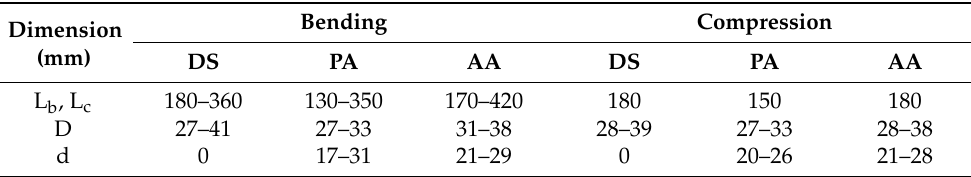
Table 3. Dimensions of the specimens for mechanical tests. L b is the clear span in flexural test (distance between nodes), L c is the sample length in compression test, D is the diameter of the cross- section of a piece of bamboo taken as the average of two perpendicular measurements made across opposite points on the outer surface, and d is the inside diameter or diameter of transverse hole.